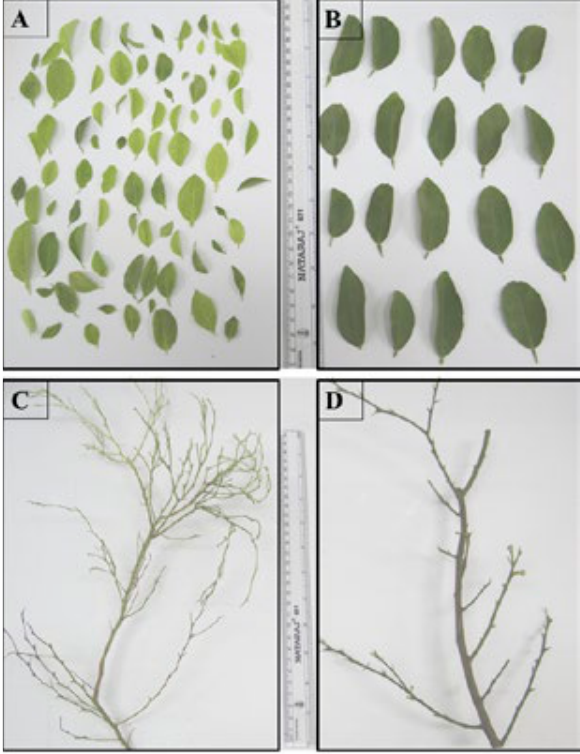
Figure 3. Leaves and branches of acid lime from witch- es’ broom symptomatic (A, C) and asymptomatic (B, D)